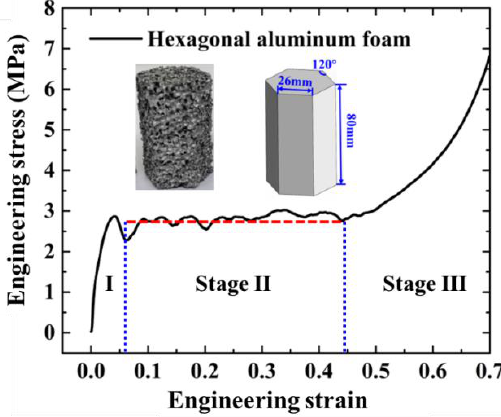
Figure 3. Stress – strain relation of hexagonal aluminum column.